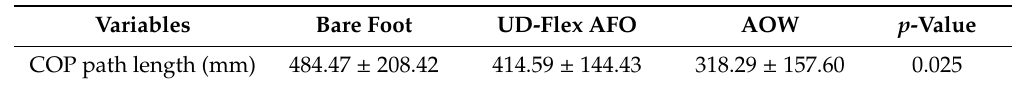
Table 2. Static balance using Zebris.